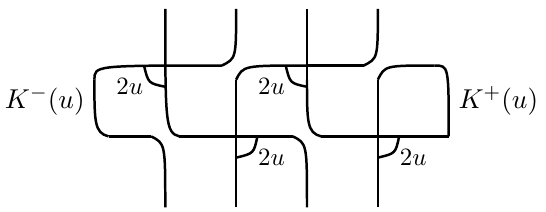
Figure 5 . The geometrical interpretation of the transfer matrix in (3.22) when the parameters ω j are given by equation (3.23).